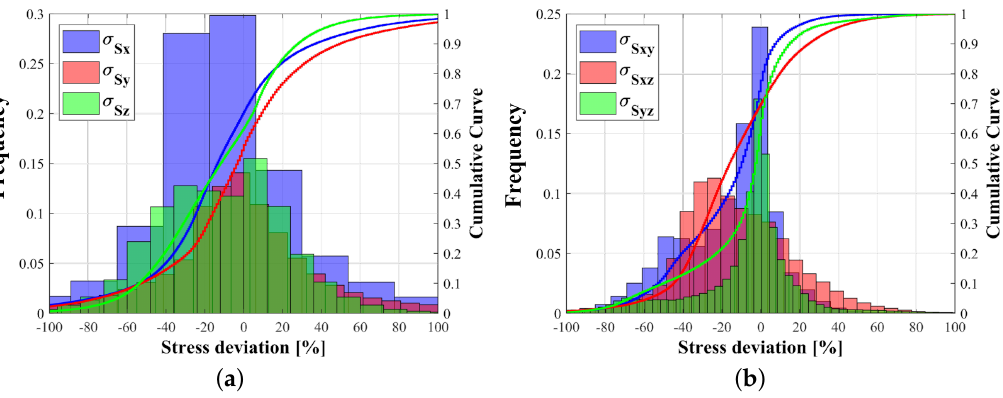
Figure 24. Statistical distributions of the stress deviations and cumulative curves in the FW-SW for normal ( a ) and shear ( b ) components.